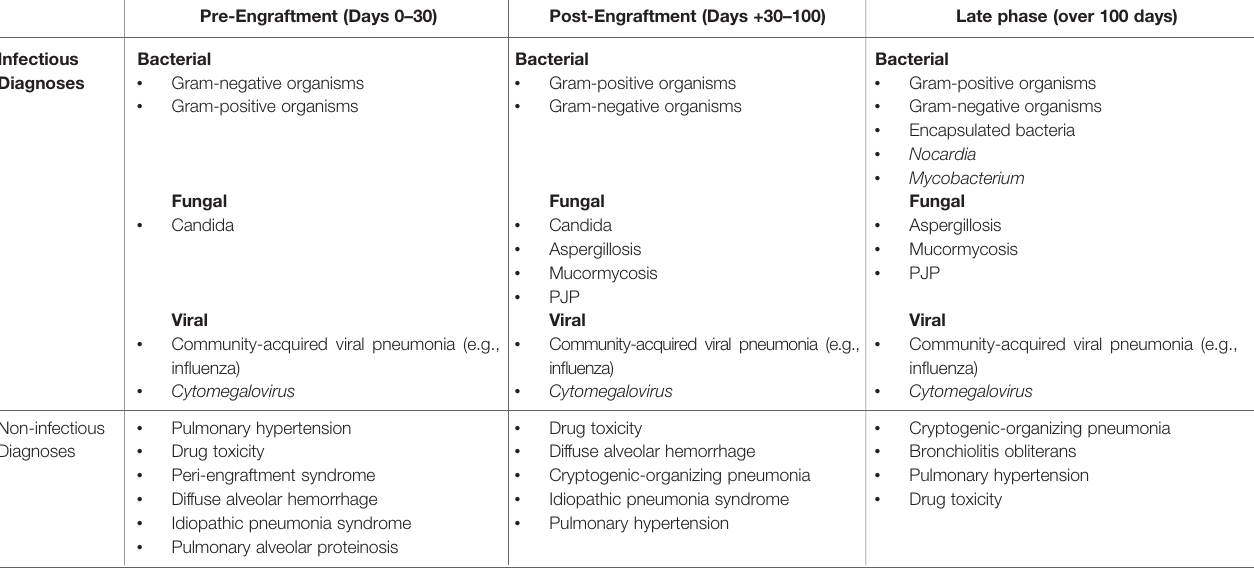
TABLE 1 | Infectious and non-infectious etiologies of pulmonary complications after stem cell transplant further subdivided by time after transplant. Pre-Engraftment (Days 0 –